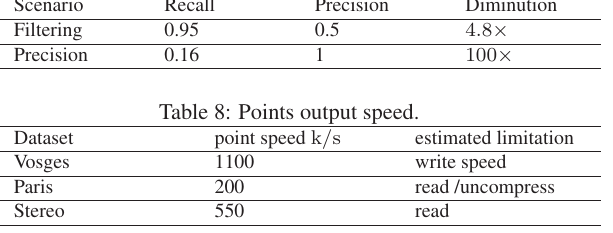
Table 6: Result of filtering. Total points